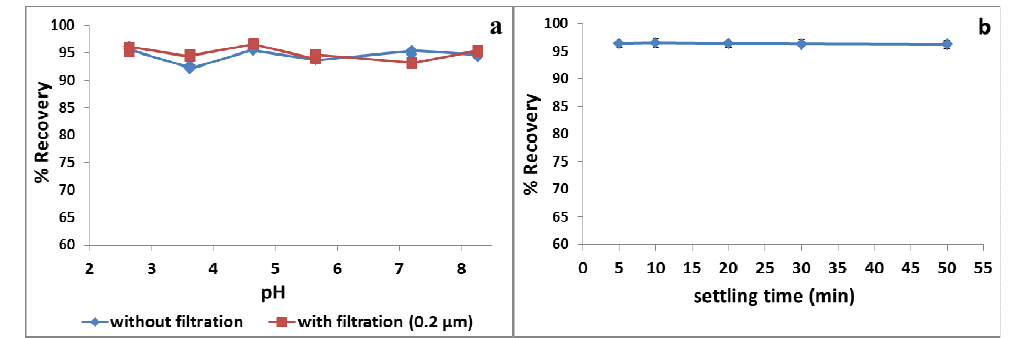
SO (w/v). The total 2 4